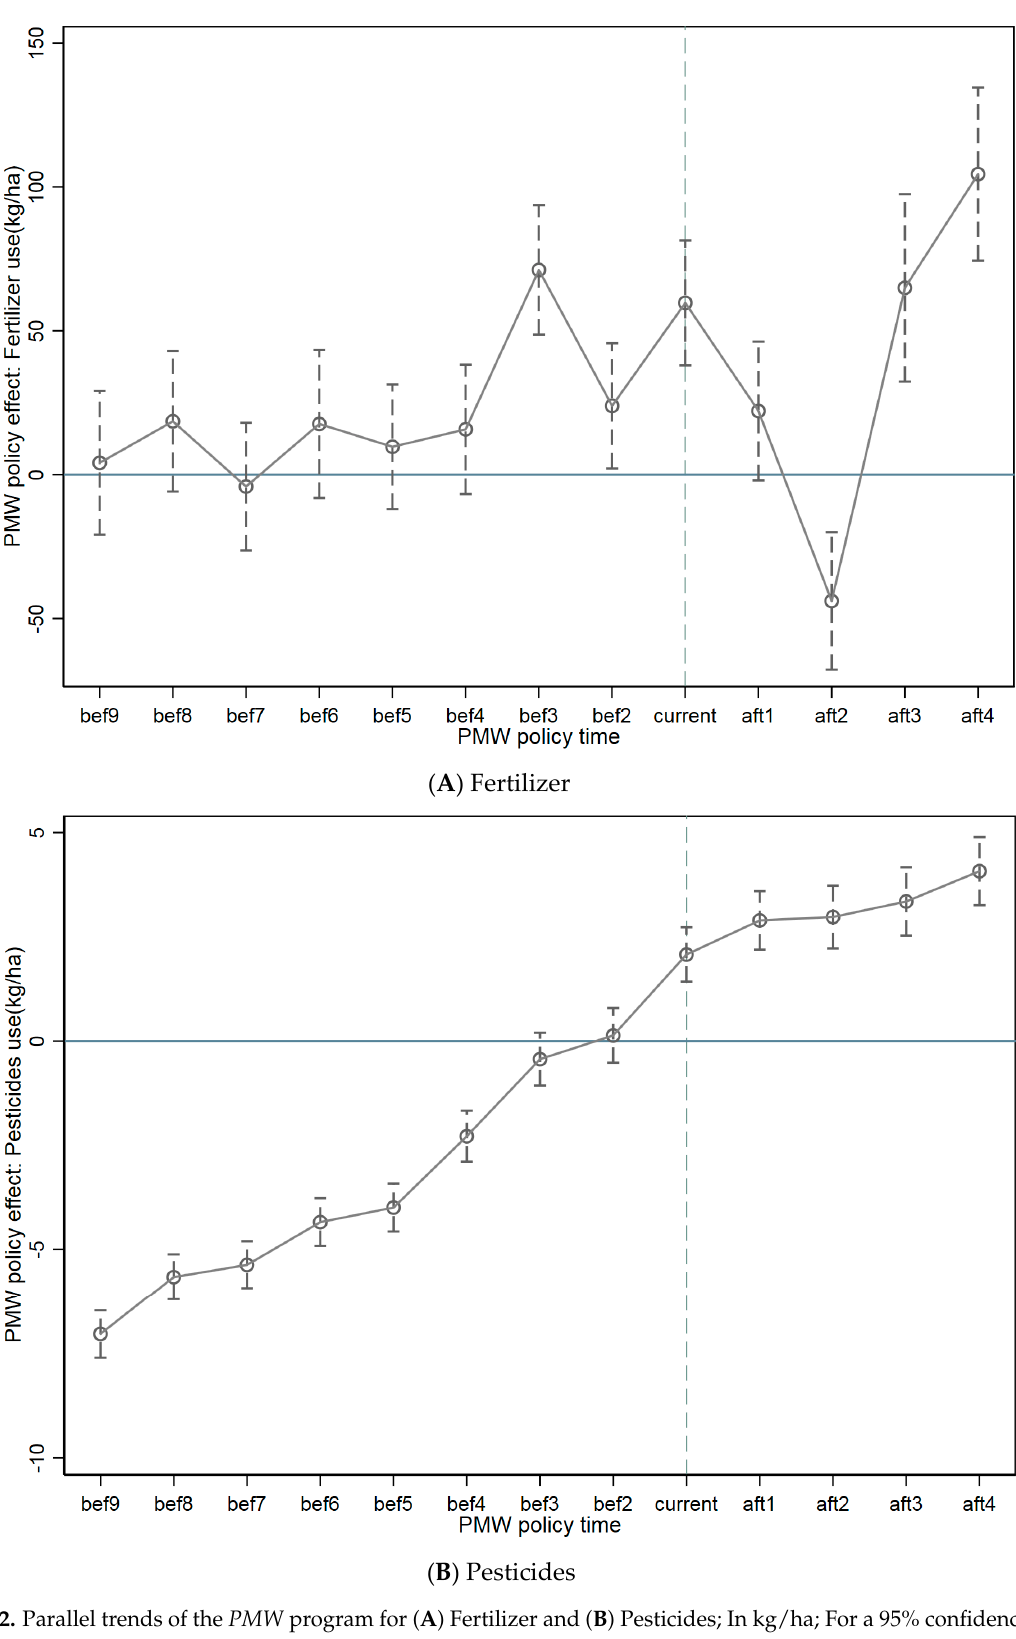
Figure A2. Parallel trends of the PMW program for ( A ) Fertilizer and ( B ) Pesticides; In kg/ha; For a 95% confidence interval. Source: Calculated from the RFOP survey data set 1997–2010.